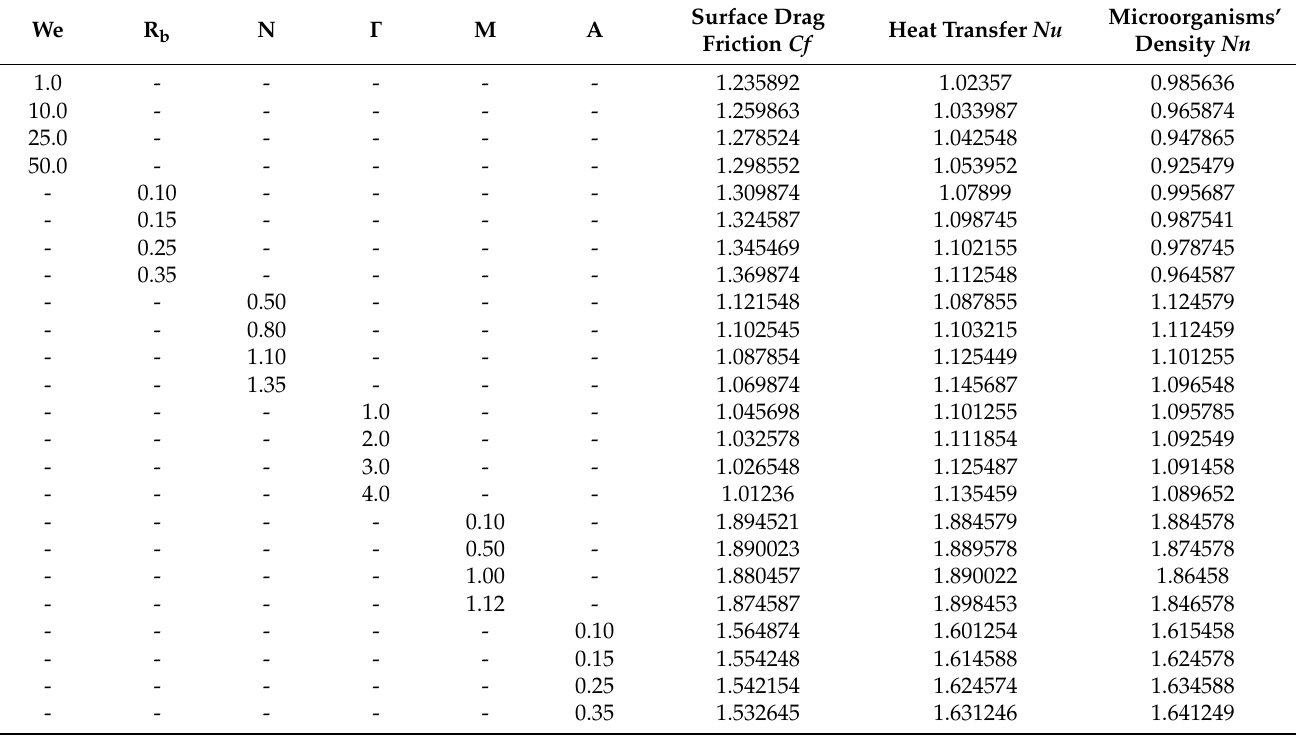
Table 2. Influence of various sundry parameters on surface drag frictiuon, heat transfer as microor- ganism’s